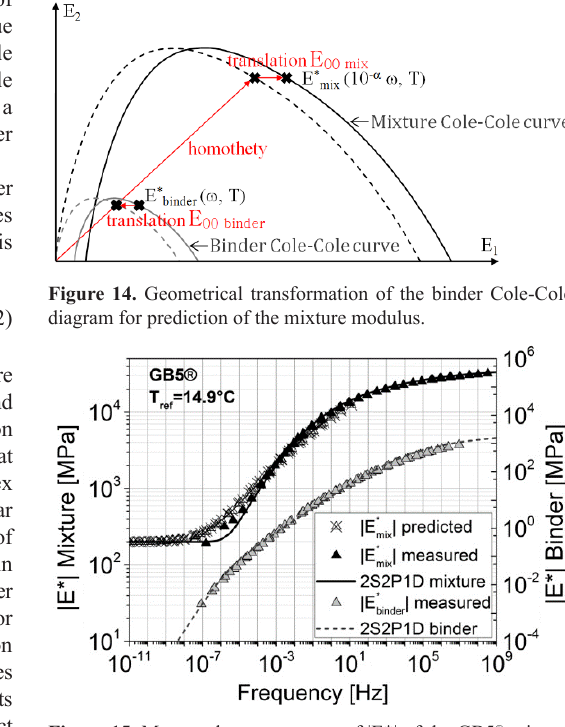
Figure 15. Measured master curves of |E*| of the GB5  mixture and its binder and predicted-from-binder |E*| master curve of the GB5 